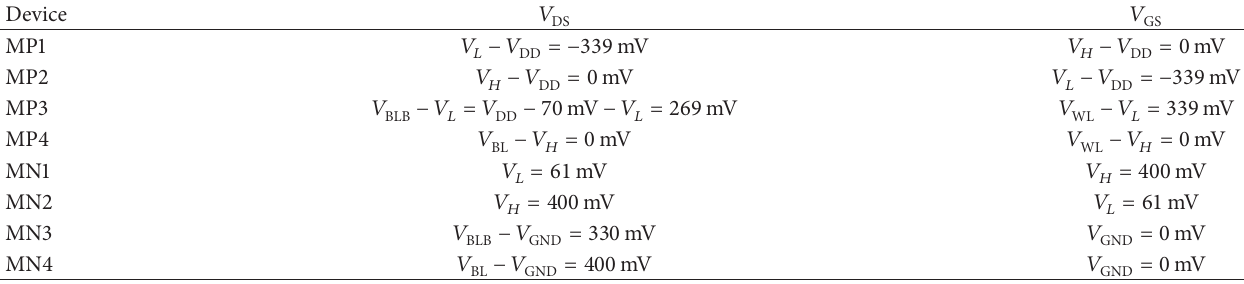
Table 2: 𝑉 and 𝑉 values of each transistor at the end of read operation at voltage difference of 70 mV between BL and BLB. DS GS Device